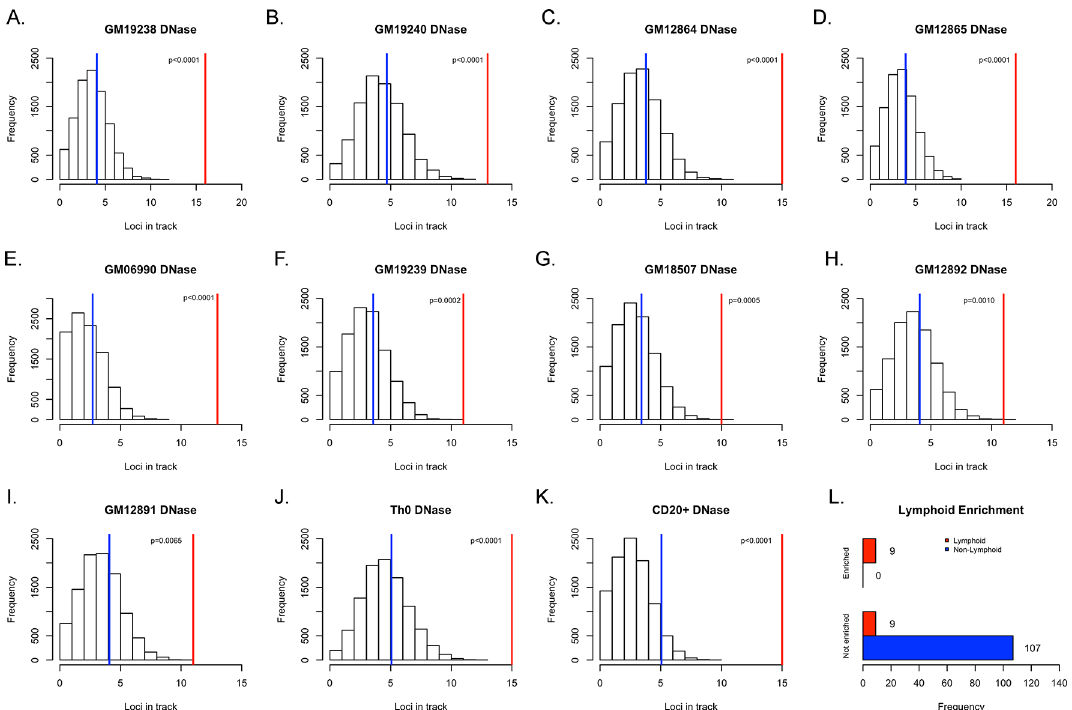
Fig 3. Enrichment of lymphoma and CLL risk SNPs in DNase-hypersensitive sites of lymphoblastoid cell lines. (A-I) These histograms represent the distribution of how many random loci overlap a specific annotation. The blue represents the mean of the empirical null distribution while the red line represents the real number of loci from the lymphoma and CLL GWAS that overlap the DNase hypersensitive site in the specified cell line: (A) GM19238 (B) GM19240 (C) GM12864 (D) GM12865 (E) GM06990 (F) GM19239 (G) GM18507 (H) GM12892 (I) GM12891. (J) Th0 (K) CD20+ (L) Summary of distribution of tissue of origin for cell lines in which lymphoma and CLL risk SNPs are either enriched (p < 0.0004) in DNase hypersensitive sites or not enriched.